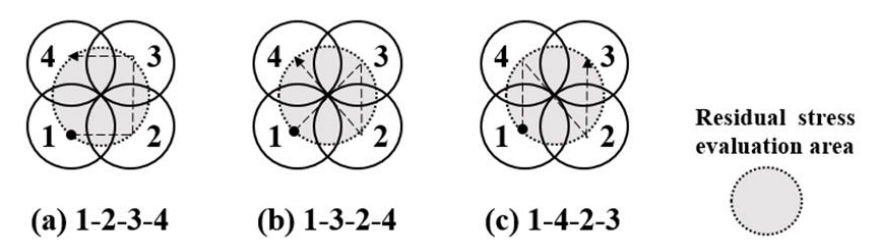
Figure 9. Schematic diagram of dimple pattern and impact sequence in 4-shots model. ( a ) 1-2-3-4; ( b ) 1-3-2-4; ( c ) 1-4-2-3.